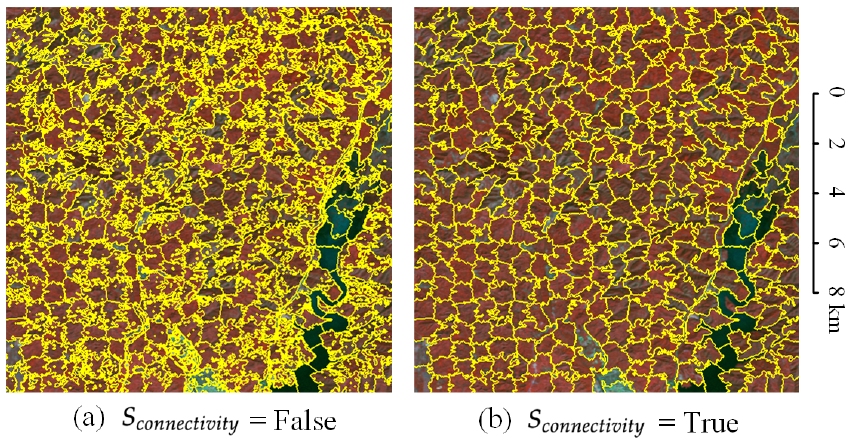
Figure 22. The effect of S connectivity on Landsat images. ( a ) S connectivity is set to False. ( b ) S connectivity is set to True.